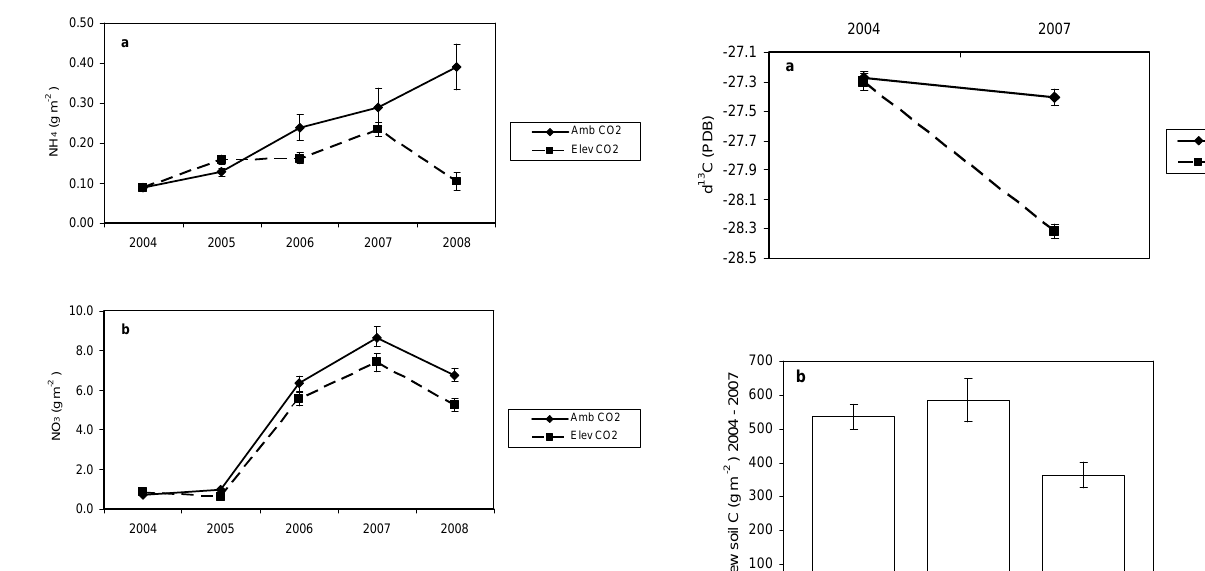
Fig. 2. Change of NH 4 -N (a) and NO 3 -N (b) at 0–10cm depth. again not significantly. Just like the coarse and fine POM fractions, the micro-aggregate protected POM C and N frac- tions were not affected by species either ( P = 0 . 564 and P = 0 . 244).